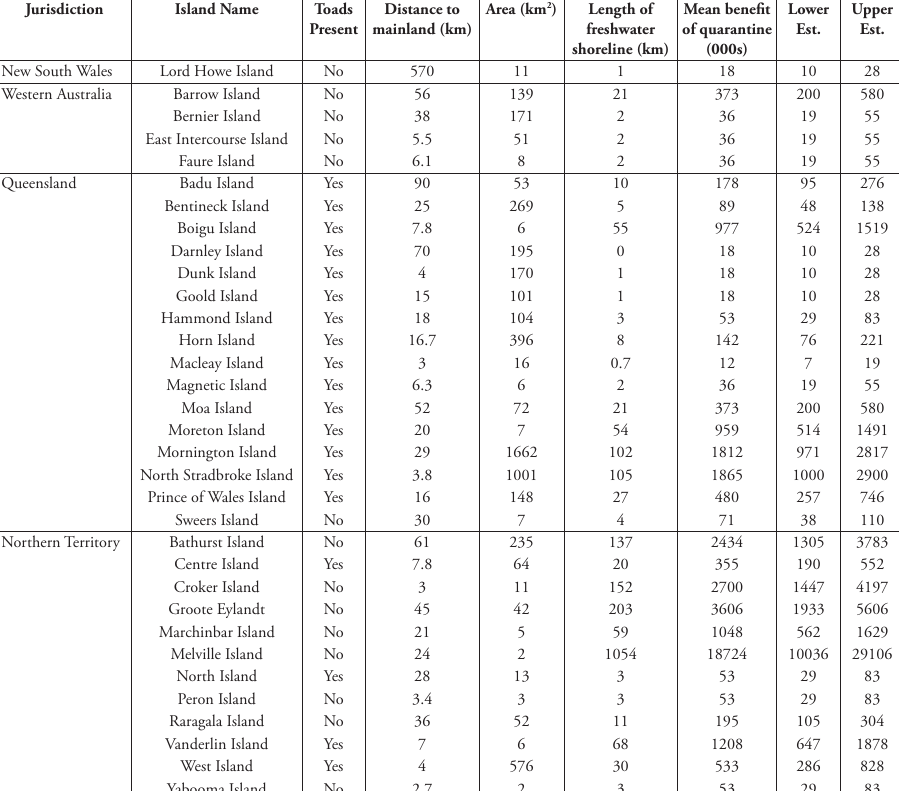
Table 2. Islands included in analyses from the top 100 islands prioritized by the Australian Common- wealth for conservation actions (Department of the Environment, Water, Heritage and the Arts (2009)). Estimates for the benefit of quarantine are in ‘000s (AUD). Mean benefit reports the cost of removal, averaging over costs calculated with the detection probabilities of each of our island